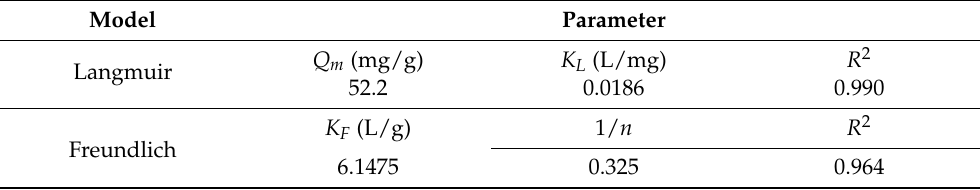
Table 5. Equilibrium models fitted As(III) adsorption onto